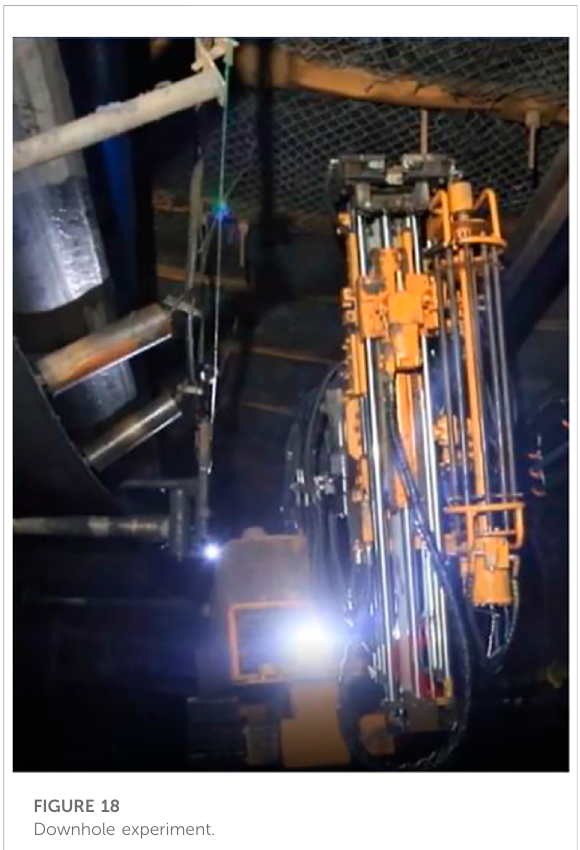
FIGURE 18 Downhole